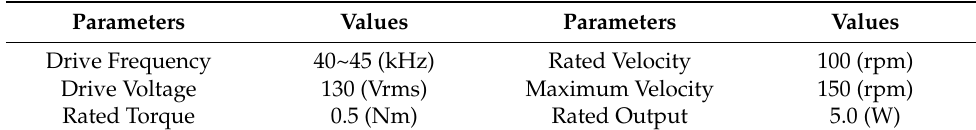
Table 1. Specifications of the Shinsei-USR60.